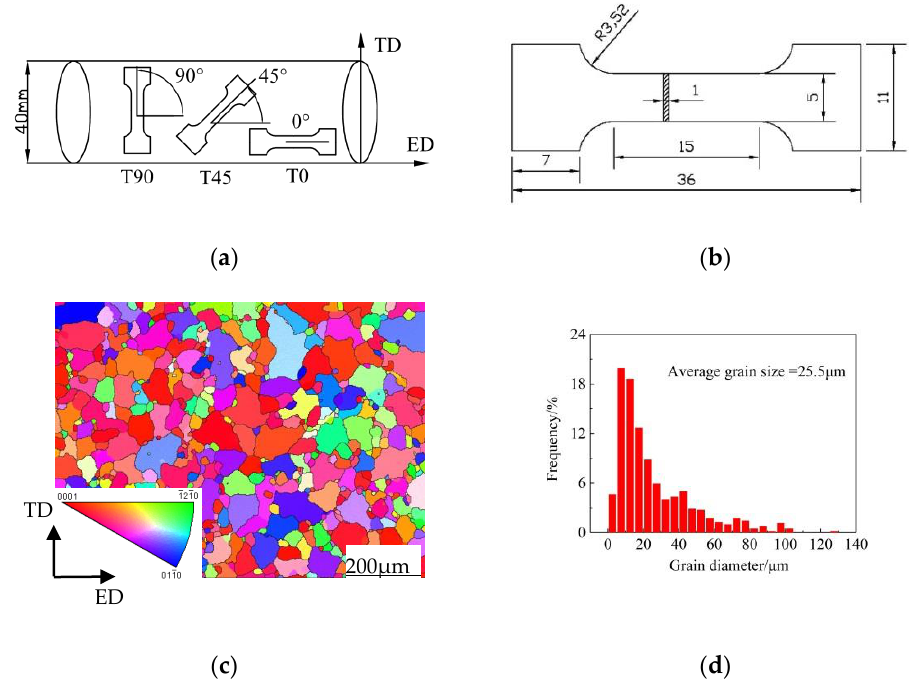
Figure 2. Specimen and microstructure: ( a ) sampling diagram, ( b ) tensile specimen, ( c ) microstruc- ture, ( d ) grain size.